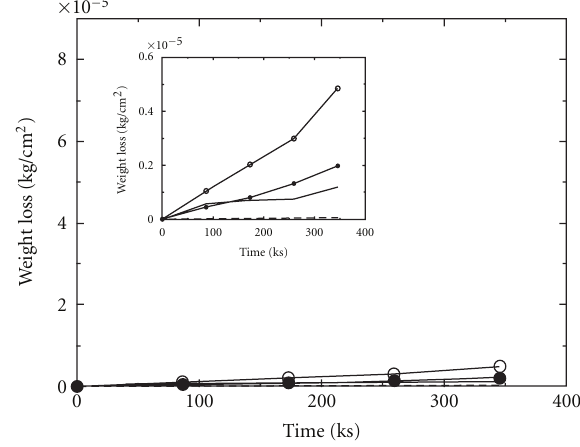
Figure 3: The weight losses of Ni 3 Al/Ni 3 V two-phase intermetallic compounds: • type 1, (cid:2) type 2, (solid line) Ni 3 (Si,Ti), and (dot- ted line) Type 304 as a function of immersion time in 0.5kmol/m 3 H 2 SO 4 solution at 303 K.